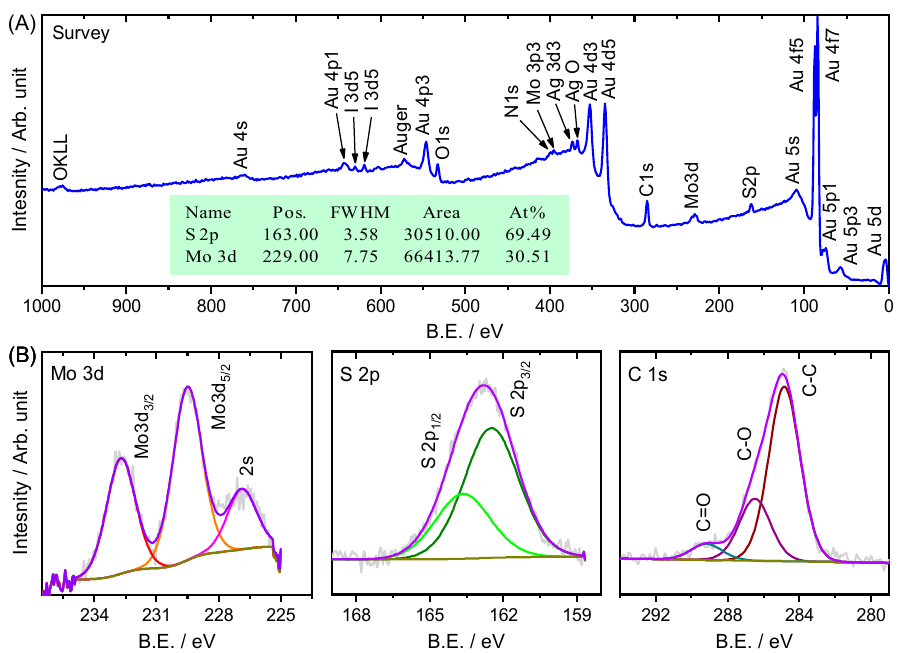
Figure 4. ( A ) Survey XPS spectrum for [Mo 3 S 7 (S 2 CNEt 2 ) 3 ]I in DMF coated on Au / ITO; Inset shows the elemental compositions for S and Mo with their respective binding energy (B.E.) positions, full width at half maximum (FWHM) values, areas, and the atomic percentages (at %); and ( B ) high resolution deconvoluted XPS spectra of Mo 3d, S 2p and ( C ) 1s lines for [Mo 3 S 7 (S 2 CNEt 2 ) 3 ]I in DMF coated on Au / ITO.